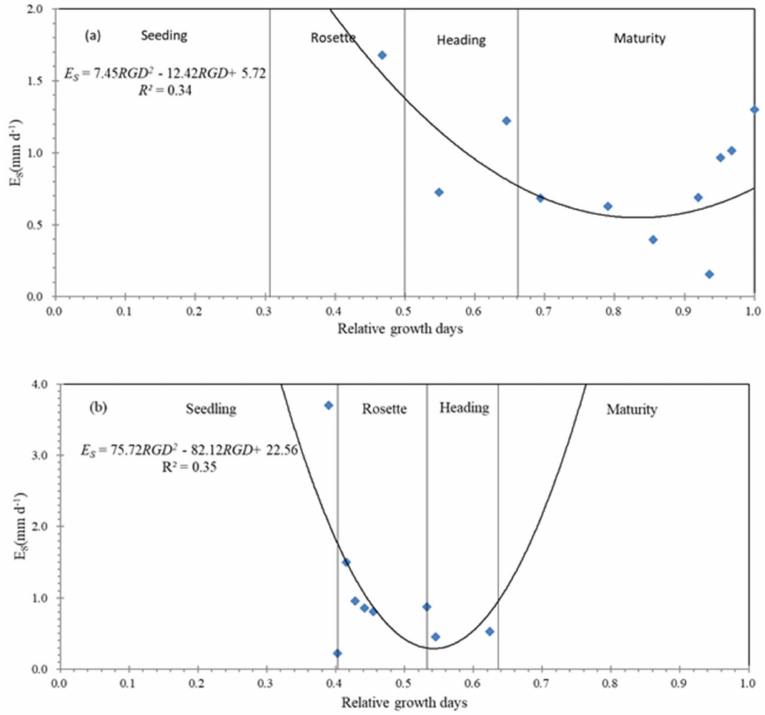
Figure 5. ( a ) Seasonal E s variation throughout growing period of the first crop; ( b ) seasonal E s variation throughout growing period of the second